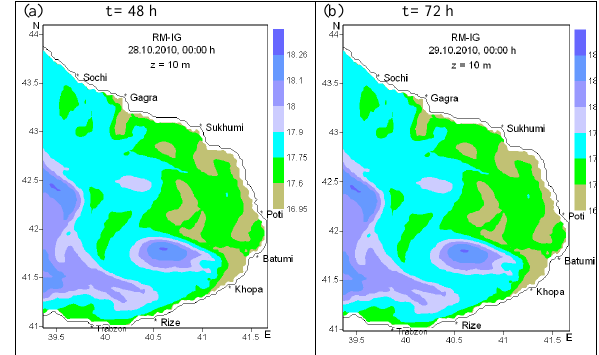
Fig. 15. The surface current fields predicted by BSM of MHI at 24 h (a) and 72 h (c) (the forecasting period is 26.10.2010, 00:00 h – 29.10.2010, 00:00 h).